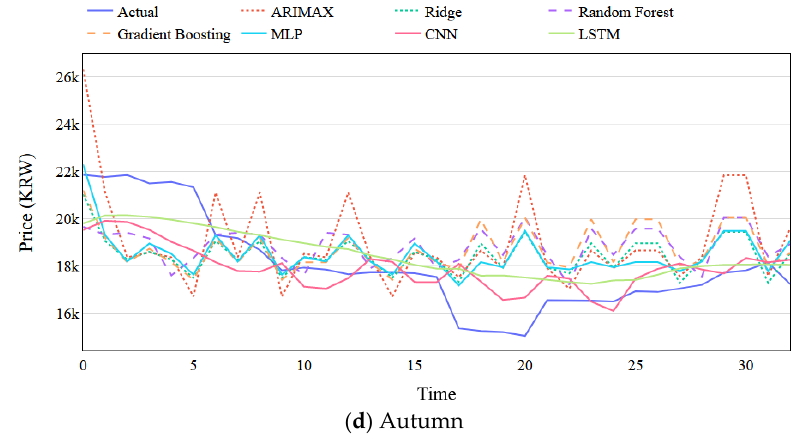
Figure 8. Seasonal pork price predictions.